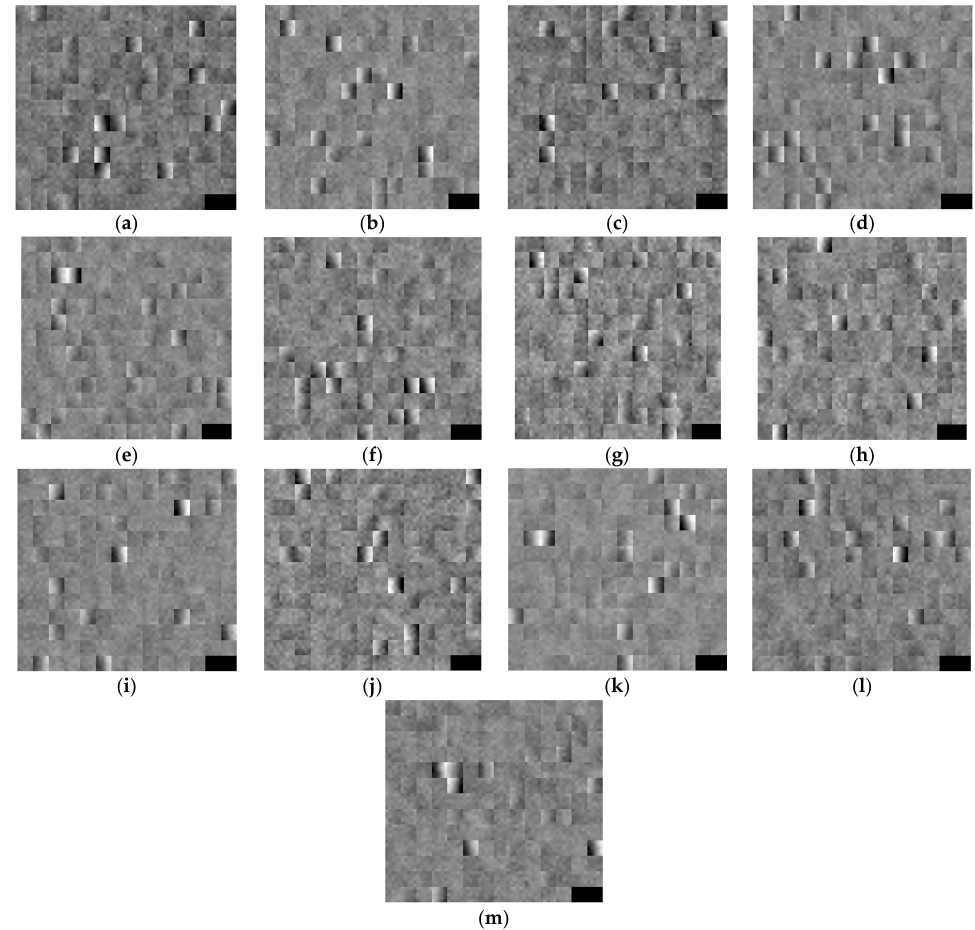
Figure 12. The obtained filters from the 1st convolution layer through training: ( a – m ) the filters from the 1st–13th trainings among 13-fold cross validation are presented, respectively.